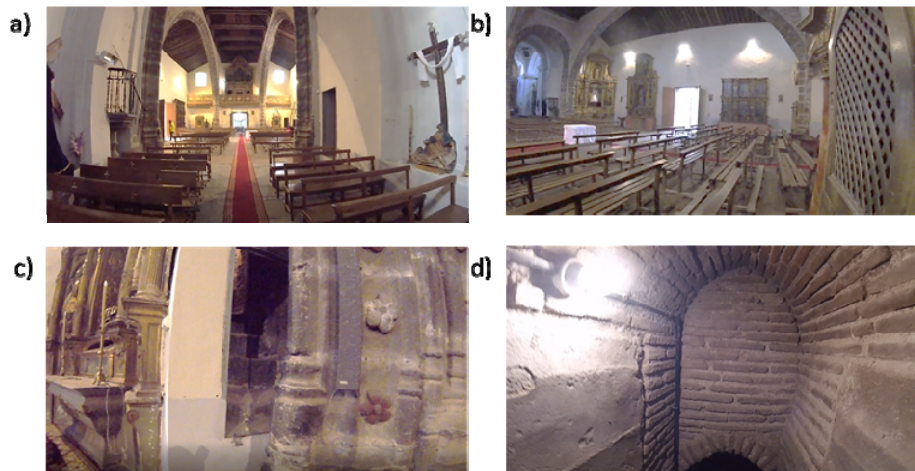
Figure 2. Inner views of the church: ( a ) view of the three naves from the transept of the church; ( b ) view of one of the segmental arches; ( c ) view of the entrance that gives access to the tower of the main nave; and ( d ) view of the narrow spaces that communicate the different levels of the tower.